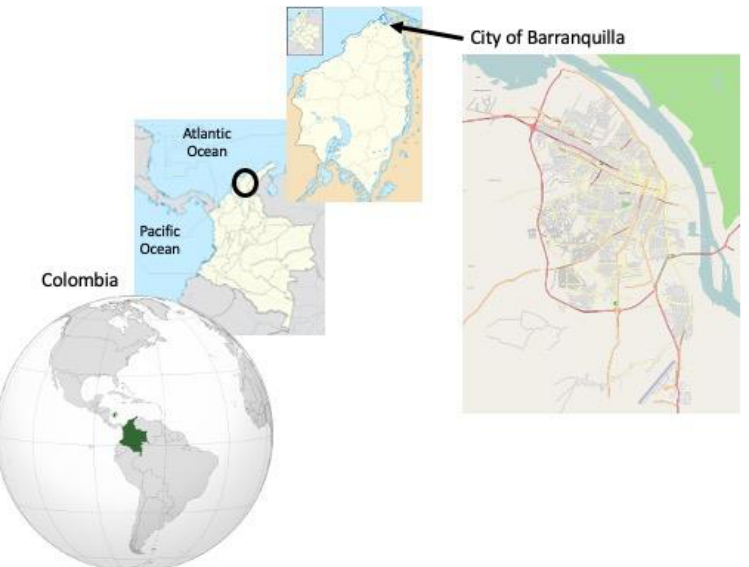
Figure 2. Location of the city of Barranquilla, Colombia.